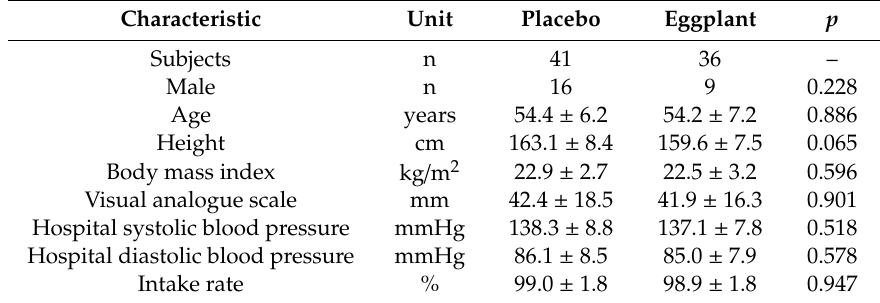
Table 1. Characteristics of participants and intake rates of test foods in the eggplant and placebo groups. Characteristic Unit Placebo Eggplant p Subjects n